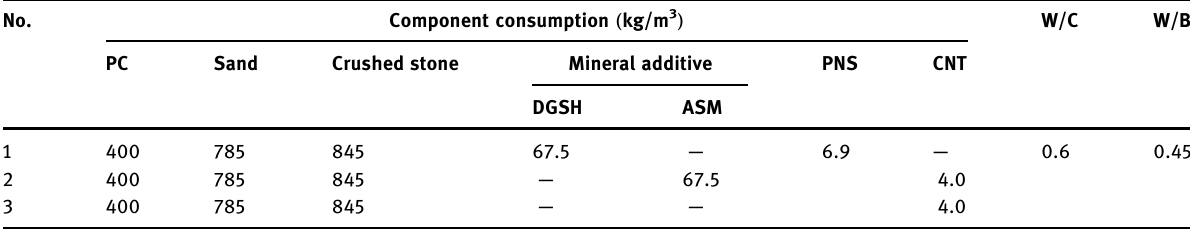
Table 16: Compositions of concrete mixtures No.